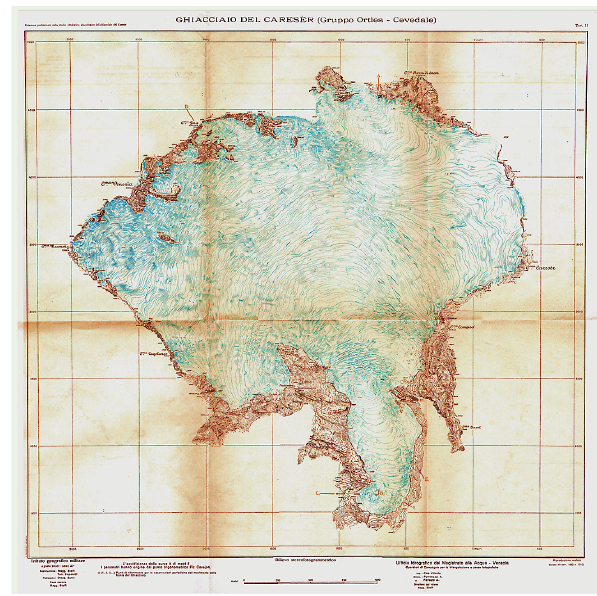
Fig. 3. (a) Snout fluctuations relative to the 1897 position (initial glacier length=3.8km). (b) Area fluctuations since 1933.